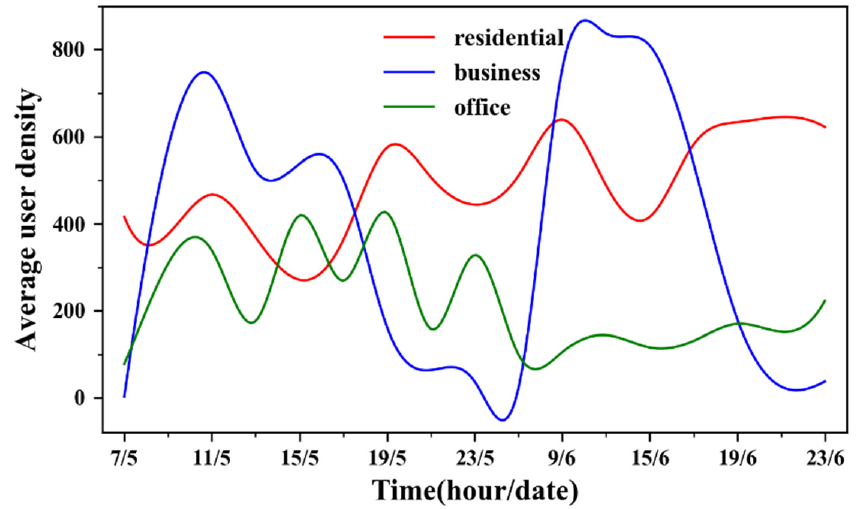
Figure 7. The temporal changes in average user density over time.